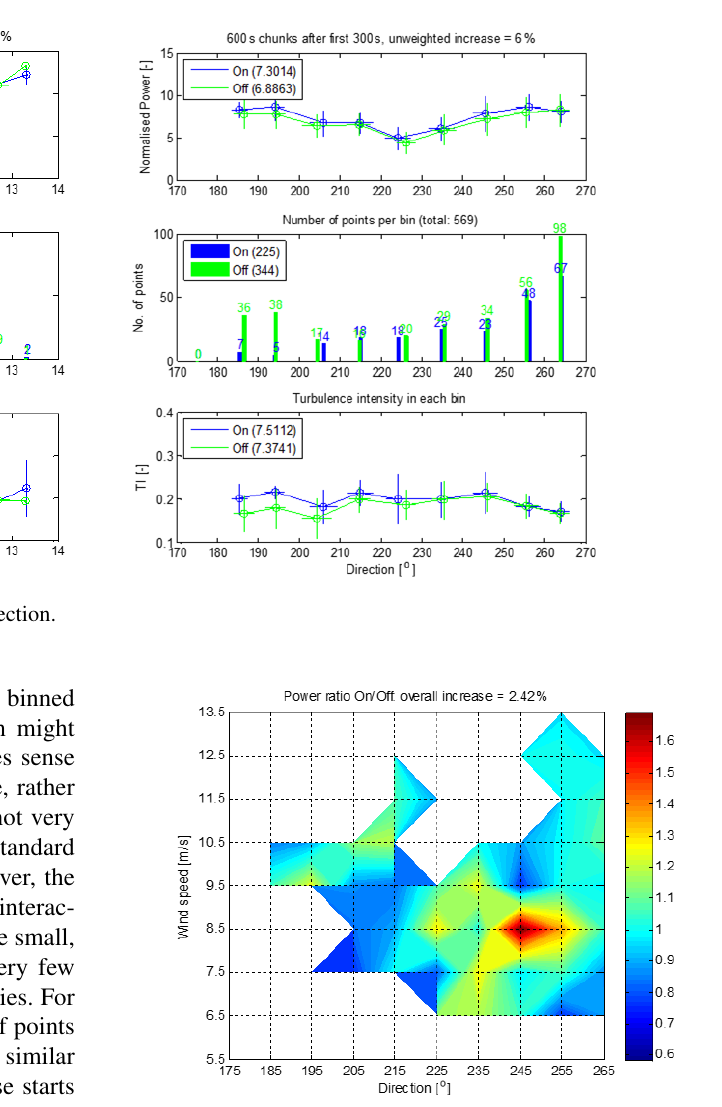
Figure 16. Power ratio binned on wind speed and